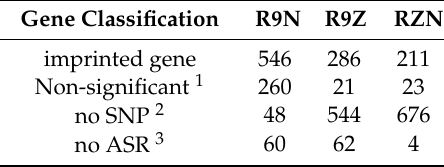
Figure 3. The Venn diagram of the genes identified in the three sets of reciprocal crosses. R9N, reciprocal hybrids of 9311 and Nip (9N + N9); R9Z, reciprocal crosses of ZS97 and 9311 (Z9 + 9Z); RZN, reciprocal hybrids of Nip and ZH11 (NZ + ZN). Red number represented the number of MEGs; blue number represented the number of PEGs.